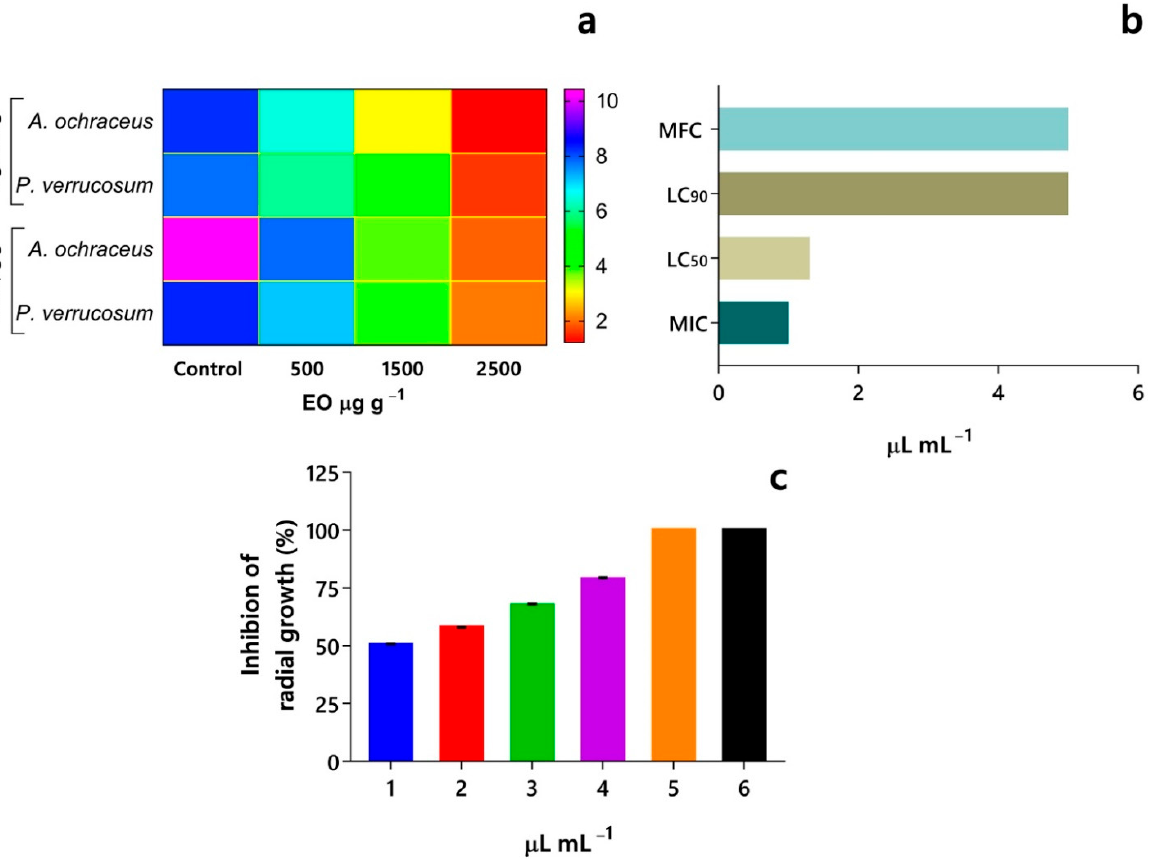
Figure 3. Microbiological effects of EOs of Z. officinale . ( a ) Effect of Z. officinale EO on growth (top) and ochratoxin A (OTA) production (bottom) in fungi in maize grains [62]; ( b ) effectiveness; and ( c ) inhibitory effect of Z. officinale EOs on the growth of F. oxysporum [39].